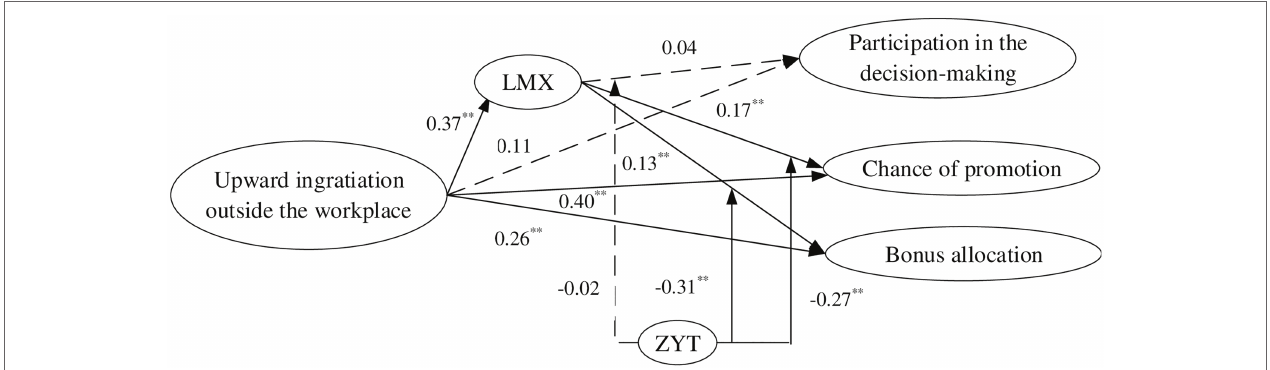
FIGURE 2 | Simplified mediation model. n = 252. ** Significant at the p ≤ 0.01 level.